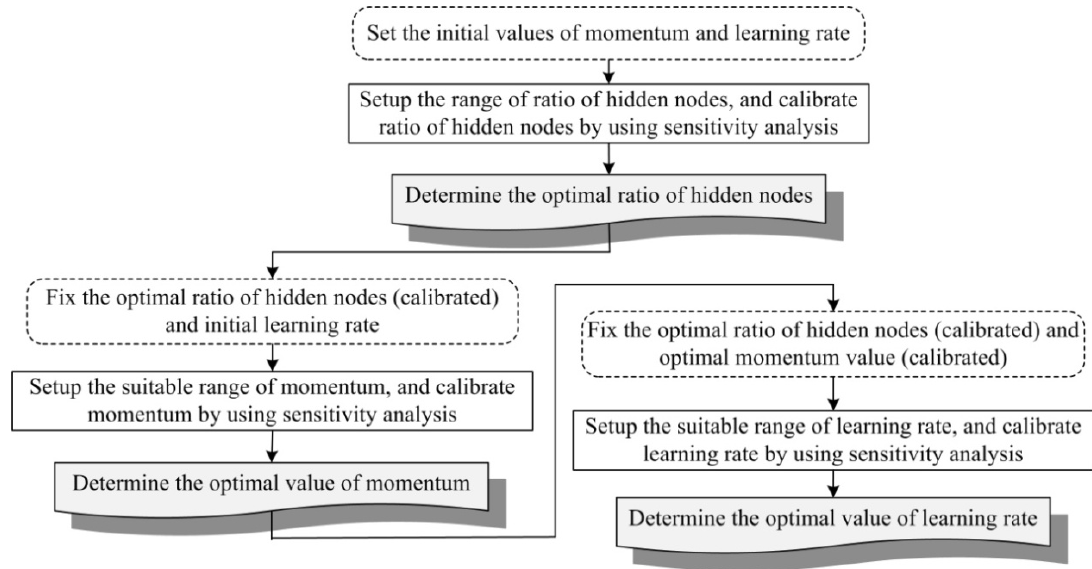
Figure 7. Trial-and-error calibration of ANN parameters.